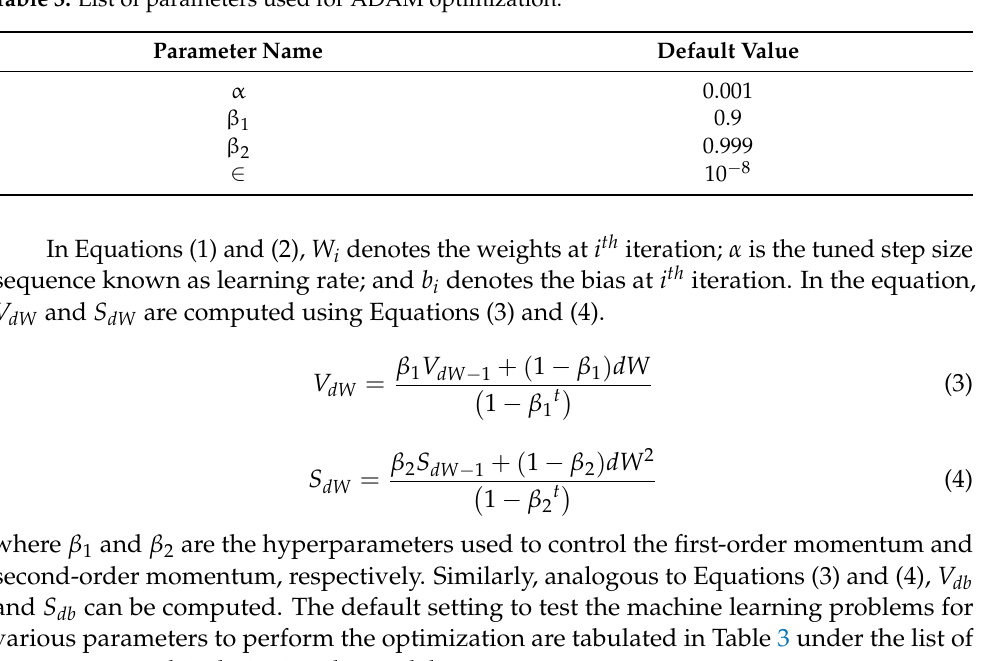
Table 3. List of parameters used for ADAM optimization.